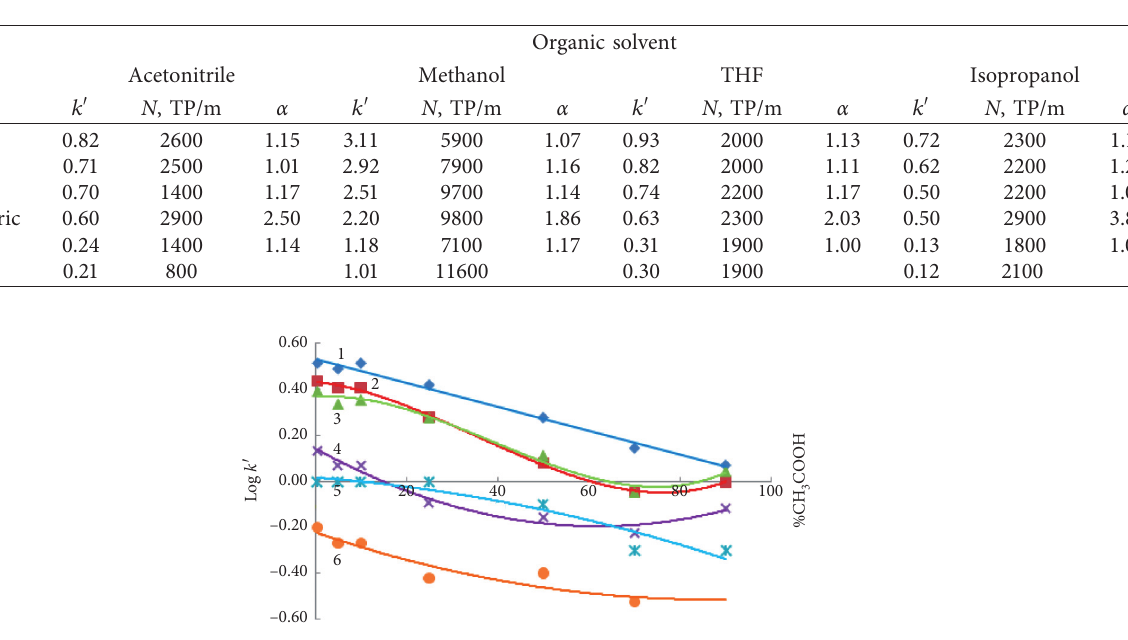
Figure 4: Effect of the methanol content in the mobile phase on the PA retention on SP-1. Acids (100 μ g/ml): 1, caffeic; 2, ferulic; 3, p -coumaric; 4, syringic; 5, salicylic; 6,